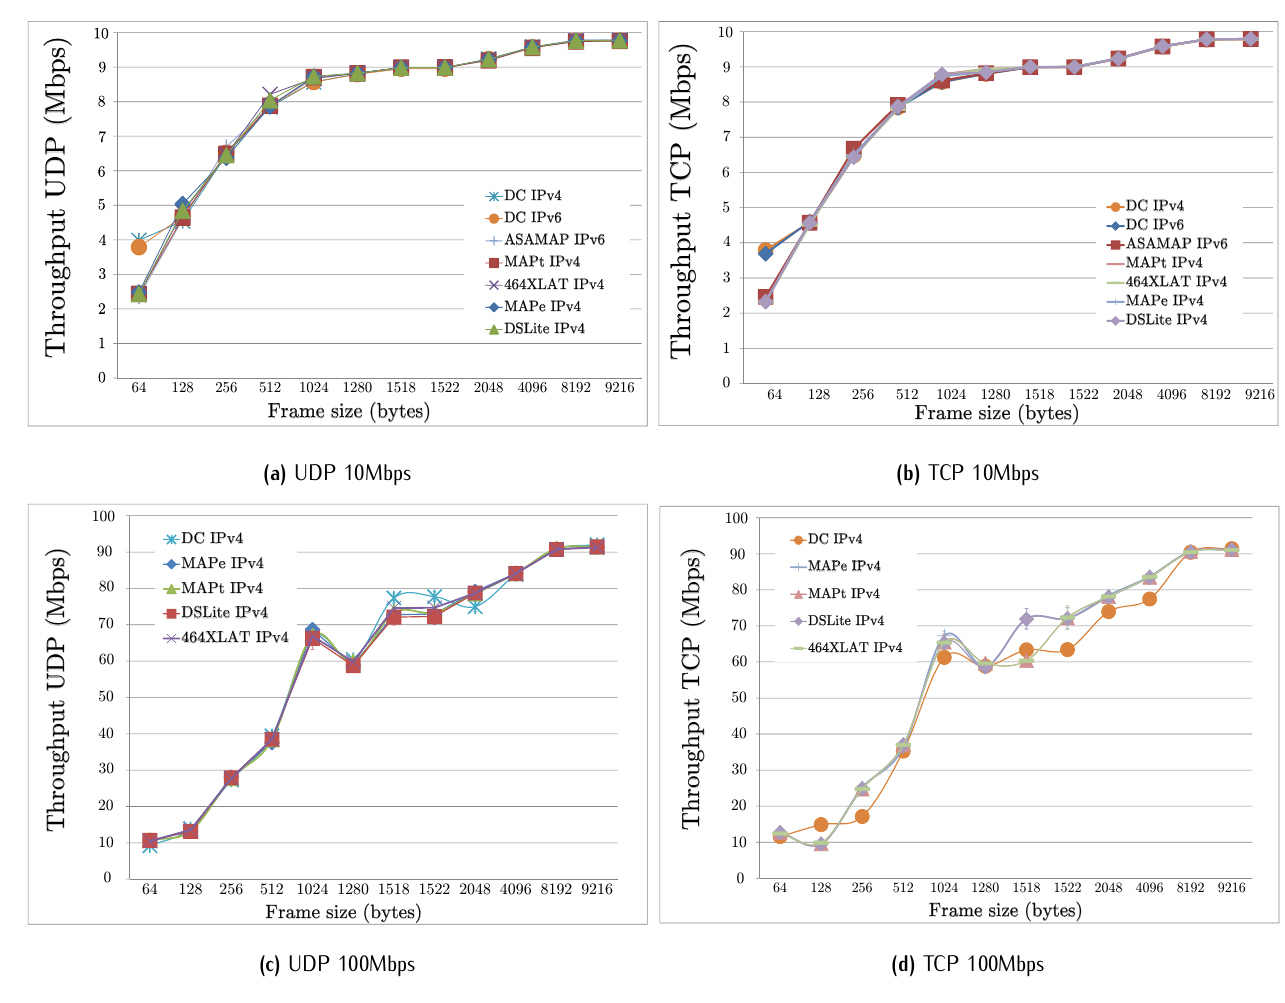
Figure 4. Throughput